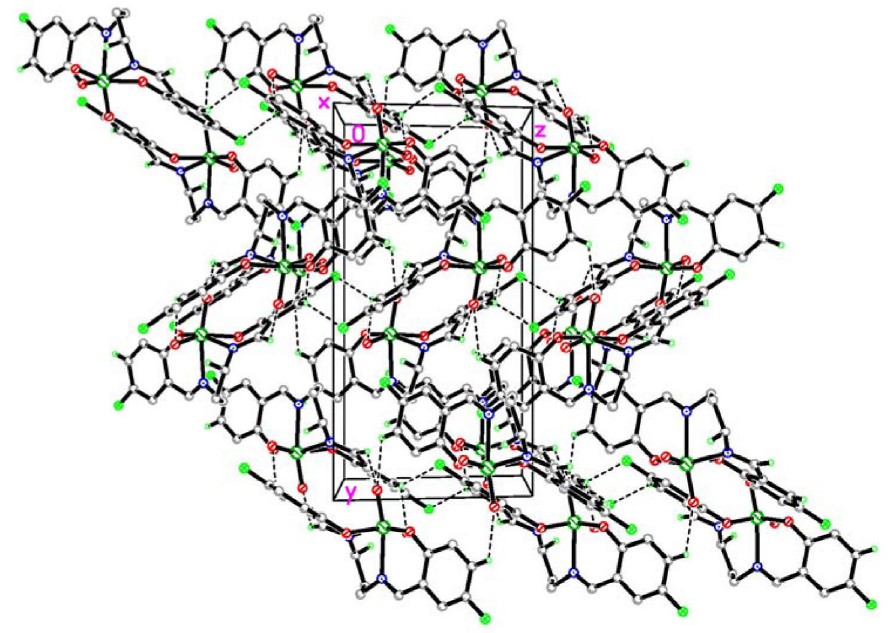
Fig. 2. Molecular packing structure of the molybdenum complex, viewed along the x -axis direction. Hydrogen bonds are drawn as dotted lines.